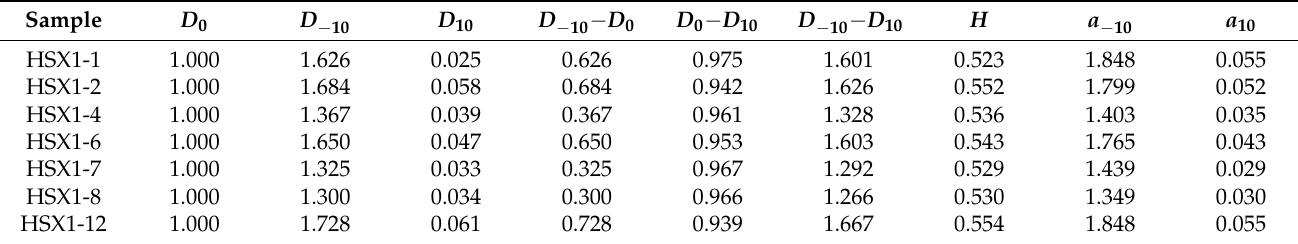
Table 4. Parameters from fractal dimension spectra of all